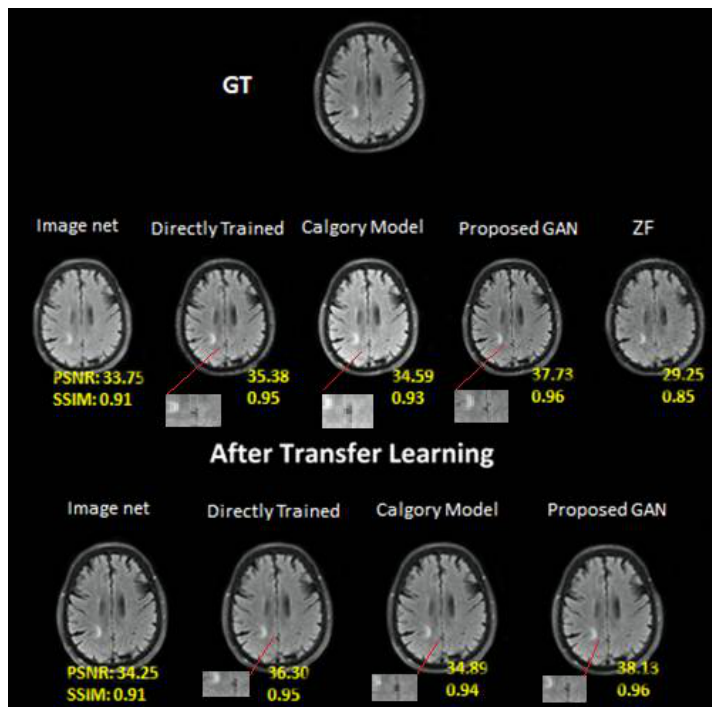
Figure 8. At AF = 4, Reconstruction results on private brain images. From left to right: (i) Image Net; (ii) Directly trained; (iii) Calgary Model; (iv) Proposed GAN; (v) ZF. In the second row: (i) Image net; (ii) Directly Trained; (iii) Calgary Model; (iv) Proposed GAN results of same slices from brain image dataset after applying transfer learning.